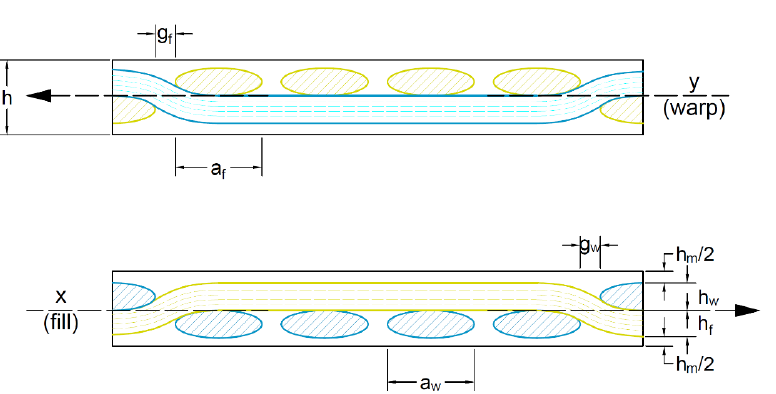
Figure 2. The geometrical parameters for woven-fabric-reinforced composite. The y and x axes cross-sectional views.